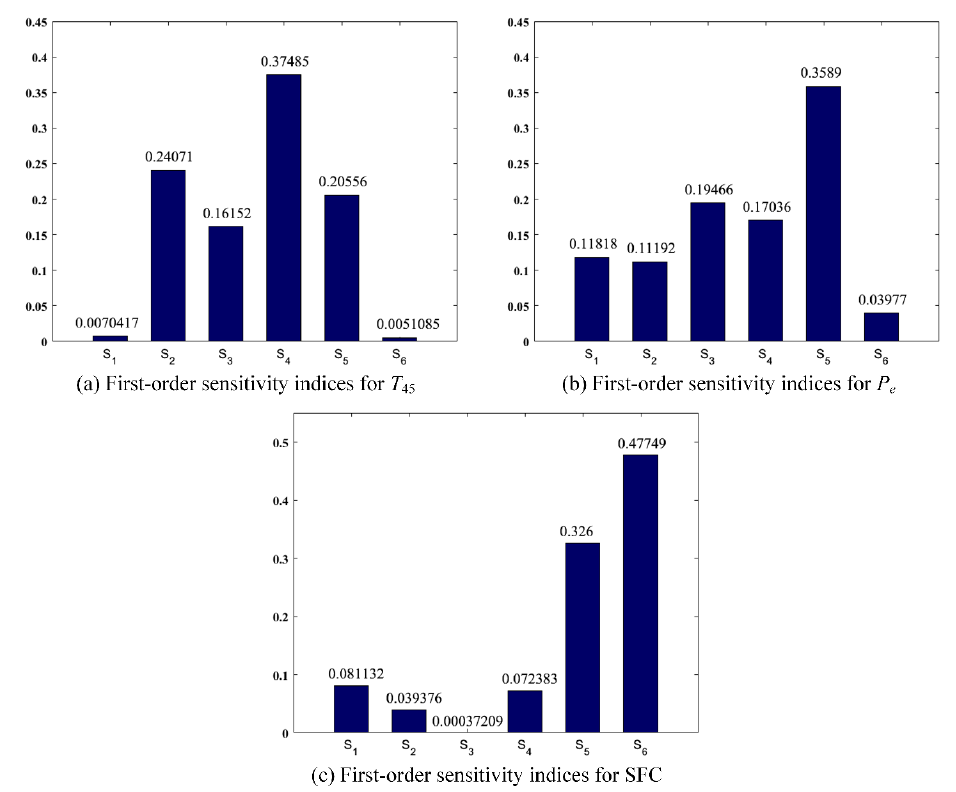
Figure 8. ( a ) The first-order sensitivity indices of six uncertain parameters for T 45 ; ( b ) the first- order sensitivity indices of six uncertain parameters for P e ; ( c ) the first-order sensitivity indices of six uncertain parameters for SFC (the value above each boxplot represents corresponding the interquartile